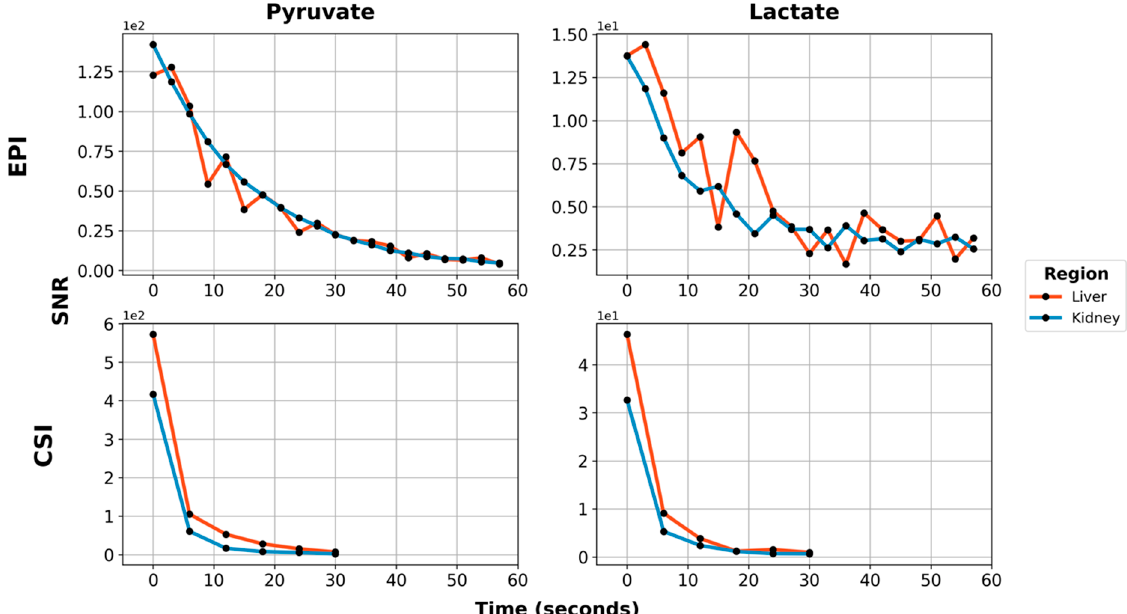
Figure 6. Dynamic metabolite curves for [1 ‐ 13 C]pyruvate (1st column) and [1 ‐ 13 C]lactate (2nd column), acquired using metabolite ‐ specific EPI (1st row) or CSI (2nd row). Red lines are the hyperpolarized signal from the liver, while blue lines are from the kidney. Signals are shown in approximate SNR units. Note that the SNR scale is different for each subplot.